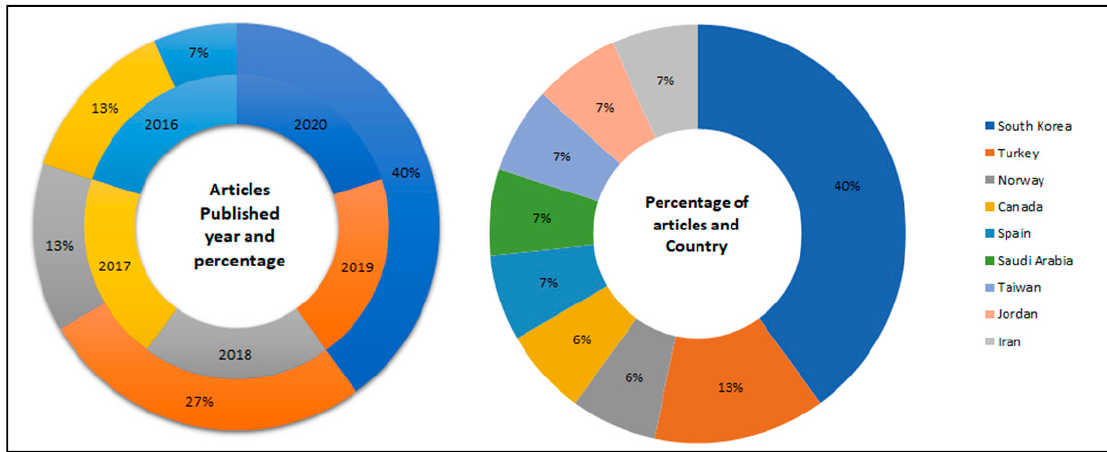
Figure 2. Percentage of articles according to the published year and country of publication.